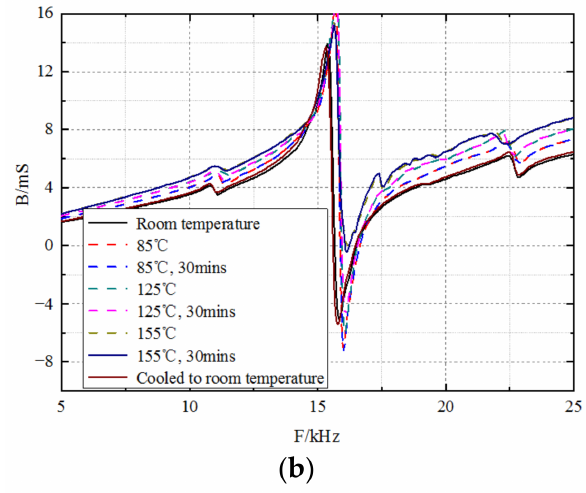
Figure 12. Admittance curves of a piezoelectric vibrator at different temperatures. Curves of the ( a ) conductance and frequency and ( b ) susceptance and frequency.